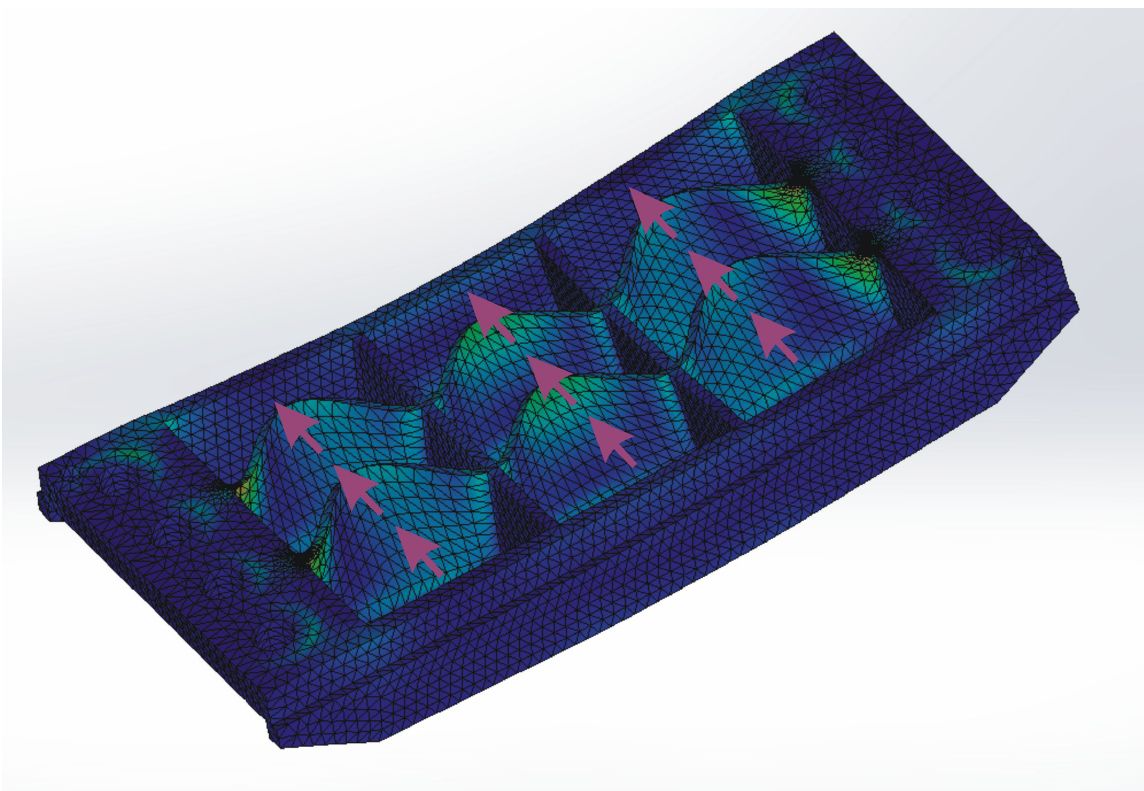
Figure 26: Forces perpendicular to the side surfaces of the retention cage housings to perform FEM